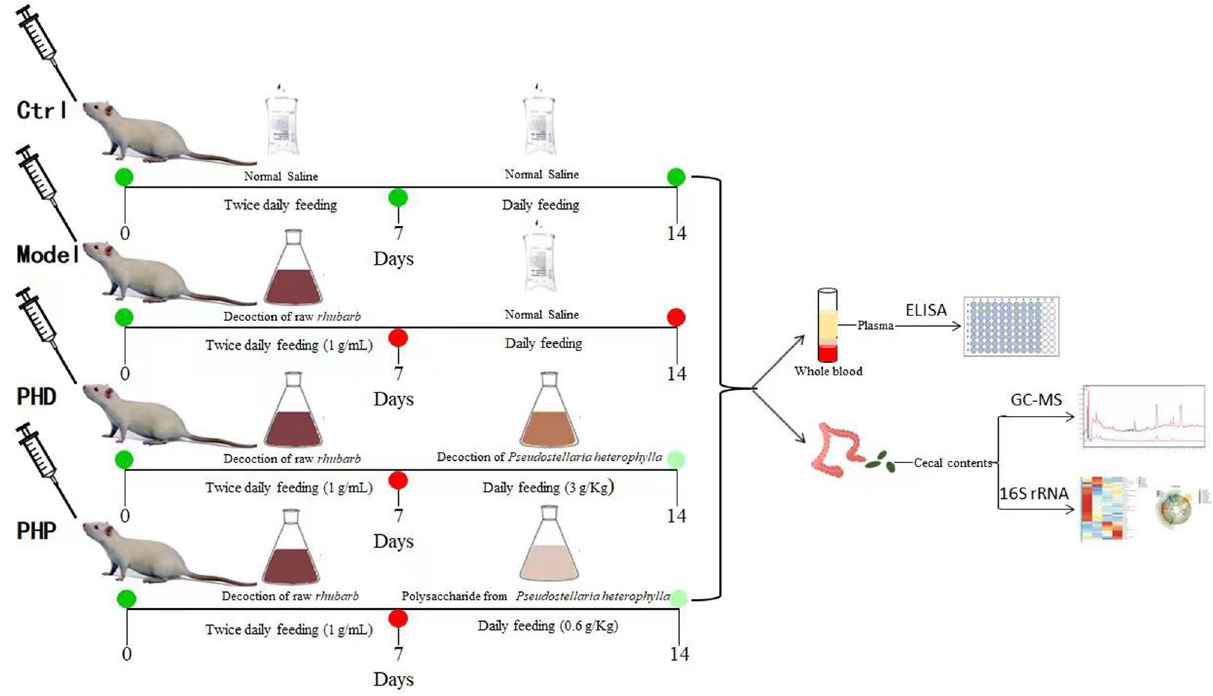
Figure 1. The Scheme of experimental plan and treatment